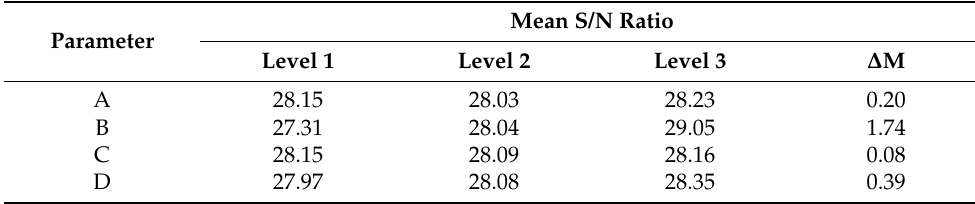
Table 4. S/N response for Cr 3 C 2 .